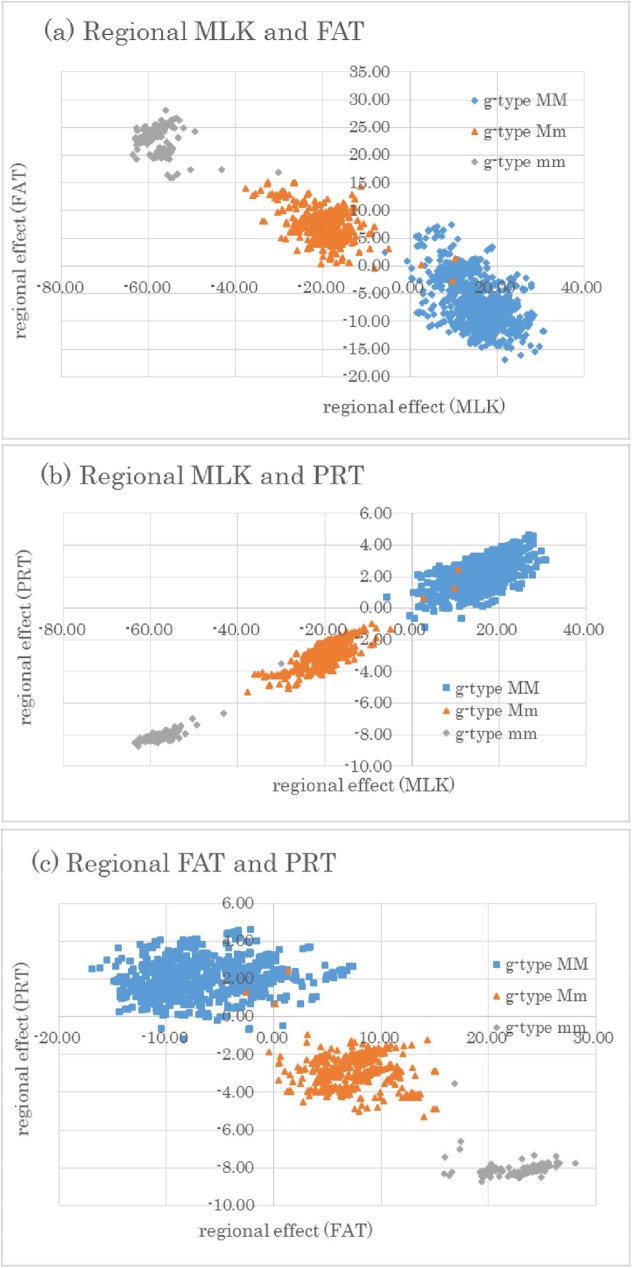
Correlation between regional genomic effects of three traits (MLK, milk; FAT, fat; PRT, protein yield) from the first window using 20 SNPs on BTA14.Individuals were categorized into three genotypes with the most significant SNP (ARS-BFGL-NGS-4939) in this region. Genotypes (g-type) MM, mm, and Mm are major and minor homozygotes and heterozygotes, respectively. The vertical axes are the regional genomic effects of (a) fat and (b, c) protein yield, and the horizontal axes are (a, b) milk and (c) fat yield.